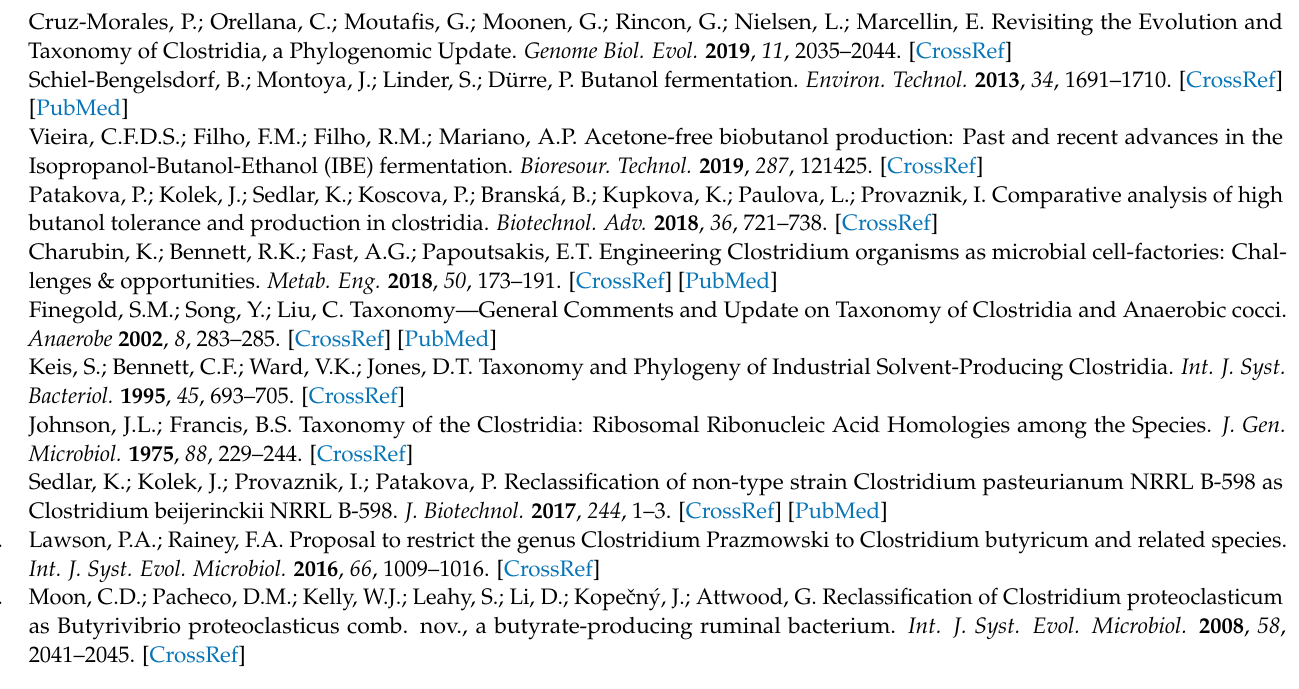
corrupted genes, Figure S2: Complete phylogenetic tree of Clostridium beijerinckii strains, Table S1: List of COG categories and number of genes present in each COG in C. beijerinckii DSM 791 T genome, Table S2: Phage DNA within the C. beijerinckii DSM 791 T genome, Table S3: CRISPR arrays in the C. beijerinckii DSM 791 T genome, Table S4: List of C. beijerinckii genomes used for analysis, Table S5: Result of dDDH analysis for complete C. beijerinckii genomes, Table S6: Numbers of genes